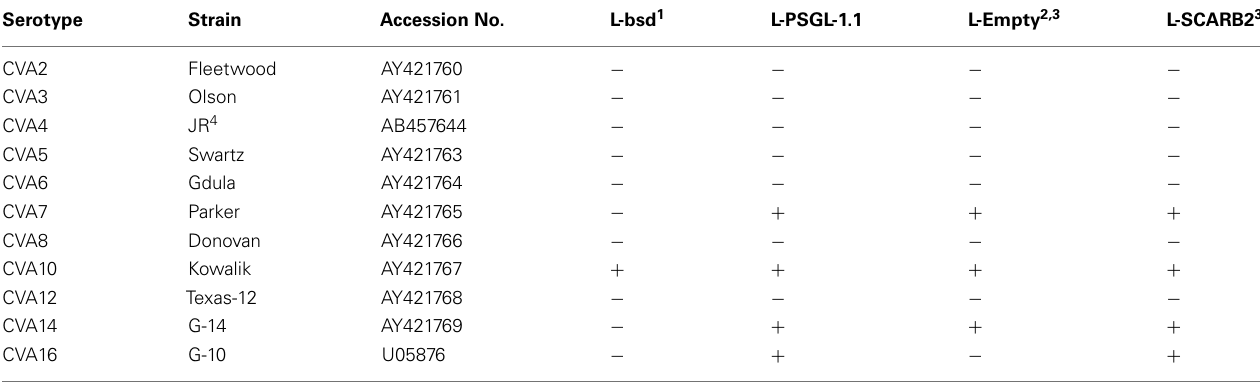
Table 1 | Induction of CPE by the HEV-A strains. Serotype